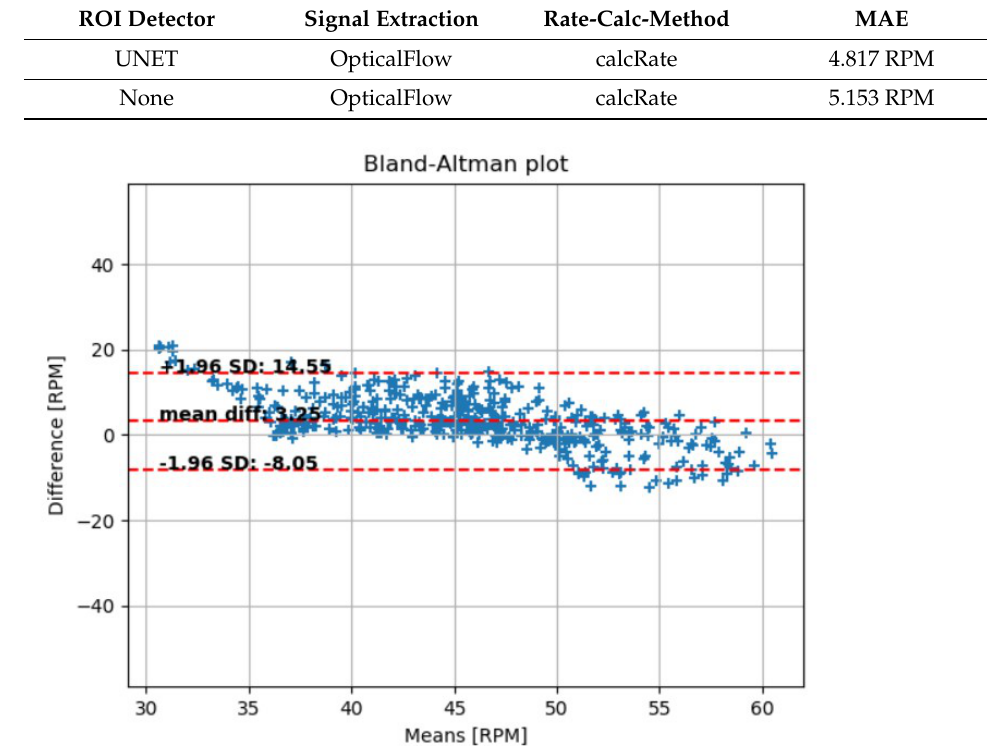
Figure 14. Comparison of the reference breathing rate and the breathing rates calculated by the Respiration Calculator Block. Every point is related to a 10-s-long input window of frames. Table 5. Statistical evaluation of the ROI detector.